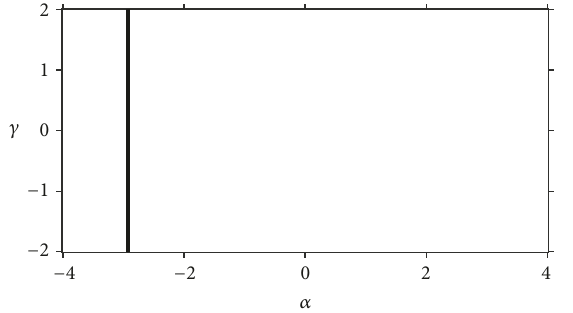
Figure 8: Unified parameter plane of 𝑥 𝐶 1−4 .